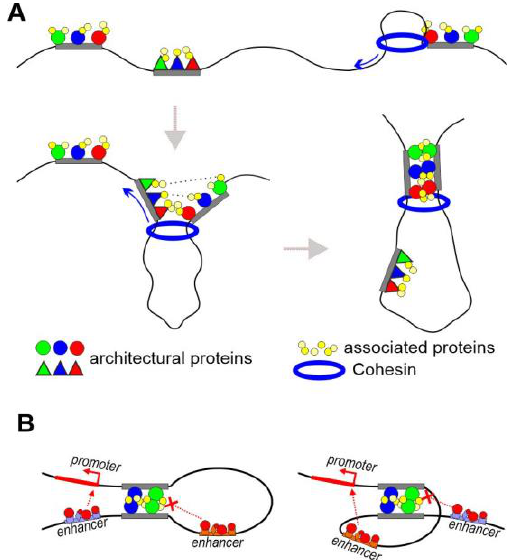
Figure 1. Combination of two models of distance interactions. ( A ) Local interaction between regu- latory elements. Various combinations of architectural proteins bind to insulators or tethering elements. The same associated proteins (such as CP190, Z4, and Chromator) bind to different combinations of architectural proteins. The specificity of distance interactions between tethering elements/insulators is determined by the number of C2H2 proteins associated with different elements that are capable of interacting with each other. ( B ) Two copies of an insulator interact in head-to-head orientation.